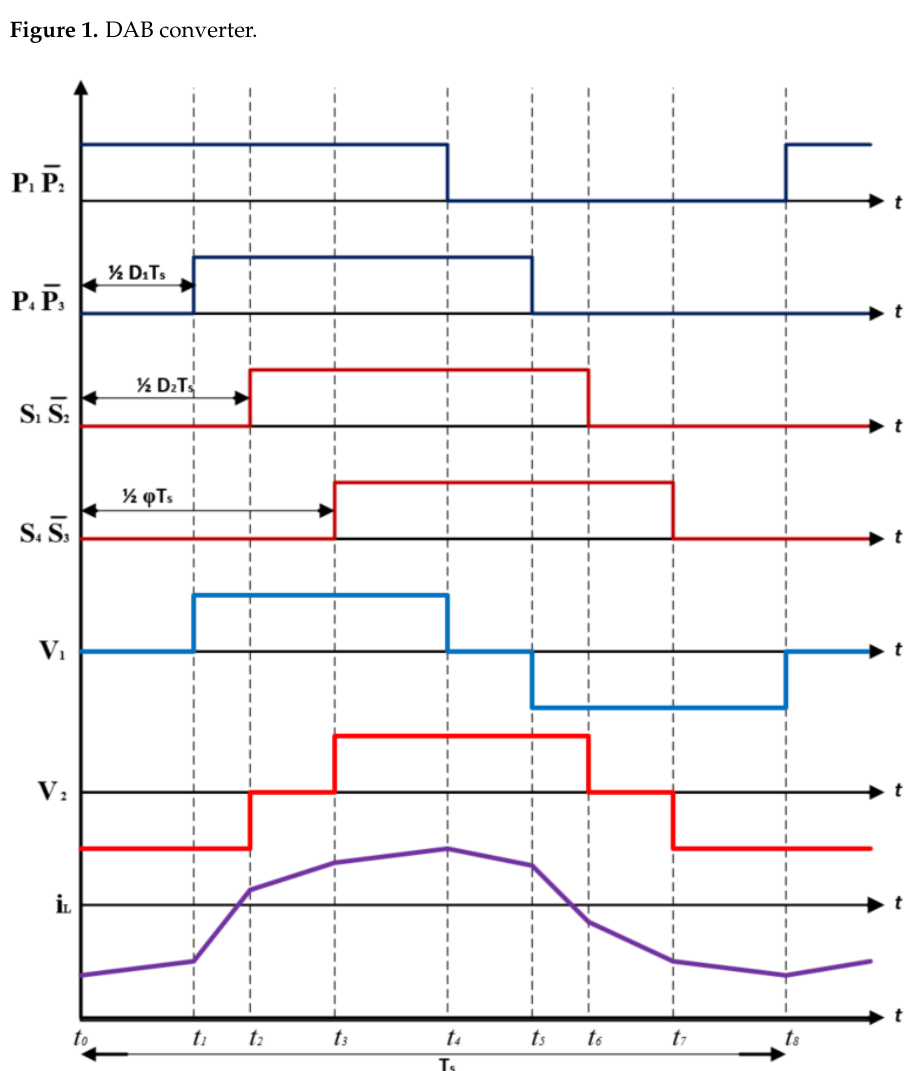
Figure 2. Gate signals, primary and secondary voltages, and current under the TPS modula- tion